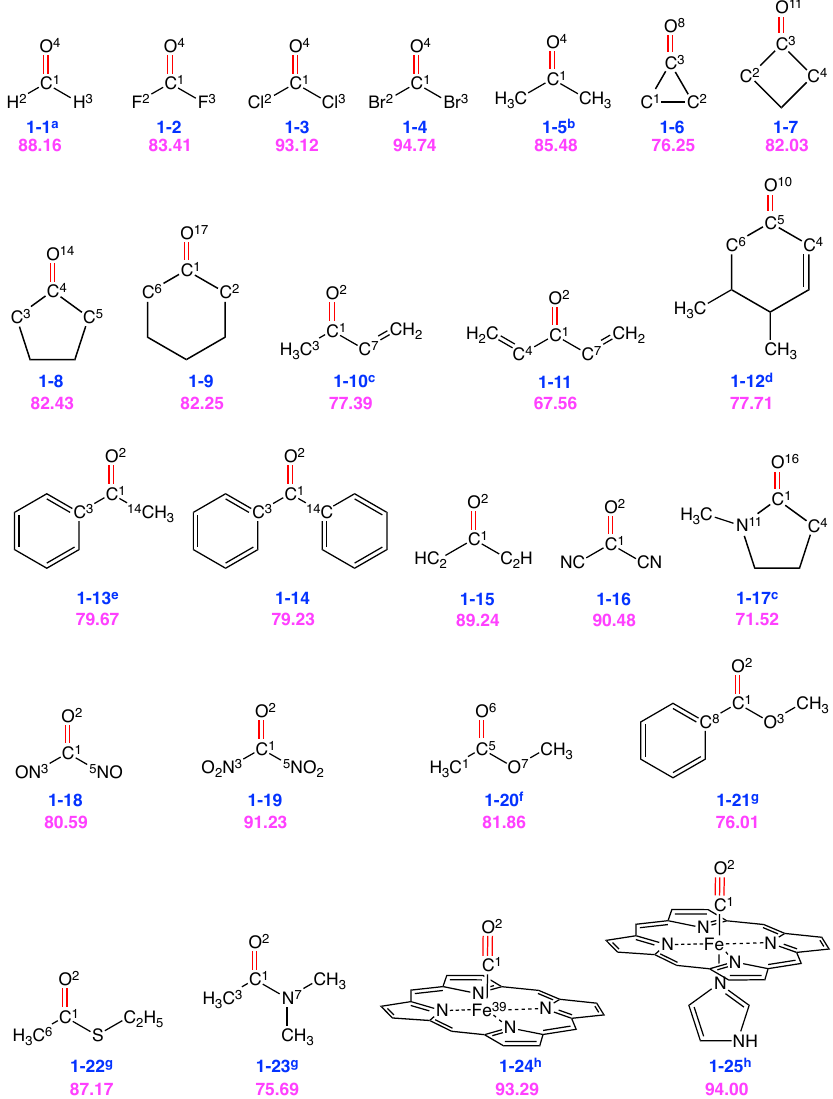
Figure 4. Group 1: 25 VSE probes with C = O or C ≡ O probe bonds in red. Below each structure, a label of n-m is given in blue; n denotes the group number (reflecting the type of VSE probe bond and m is the number of the molecule within this group. Vibrational probe labels with superscripts are taken from the literature (a [95], b [5,96], c [96], d [5,7,25,28], e [5,13,97], f [13], g [13,26], h [14,15,98]). The corresponding performance score as VSE probe is given in purple. The number as superscript in the 2D structure refers to atom index in the molecule. The superscripts are shown only for the atoms whose associated local modes participate in the C = O or C ≡ O normal mode with more than 5%